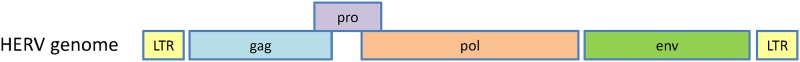
Genetic structure of HERVs.LTRs (Long Terminal Repeat) regions bound the genome with four major viral genes: gag (encoding matrix and retroviral core), pol (reverse transcriptase and integrase), pro (protease), and env (envelope).